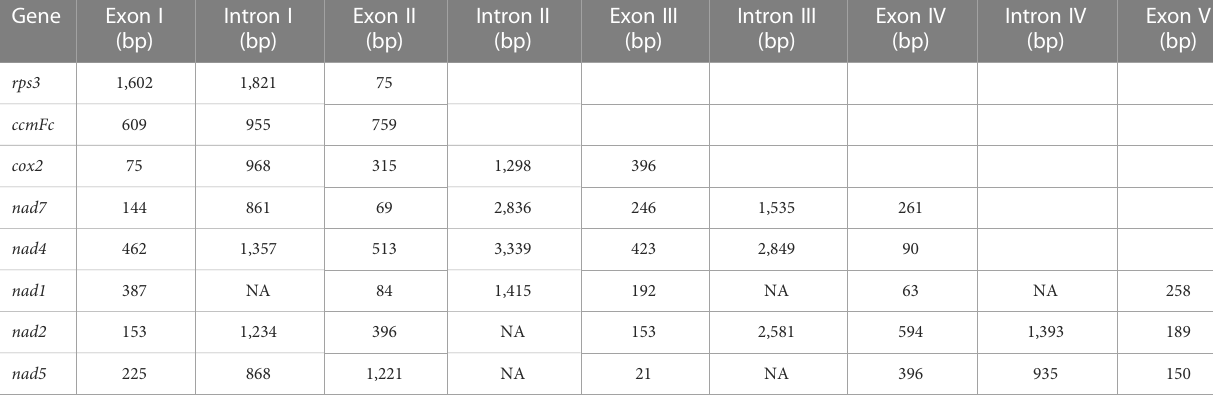
TABLE 2 The length of exon and intron in the A. of fi cinalis mitochondrial